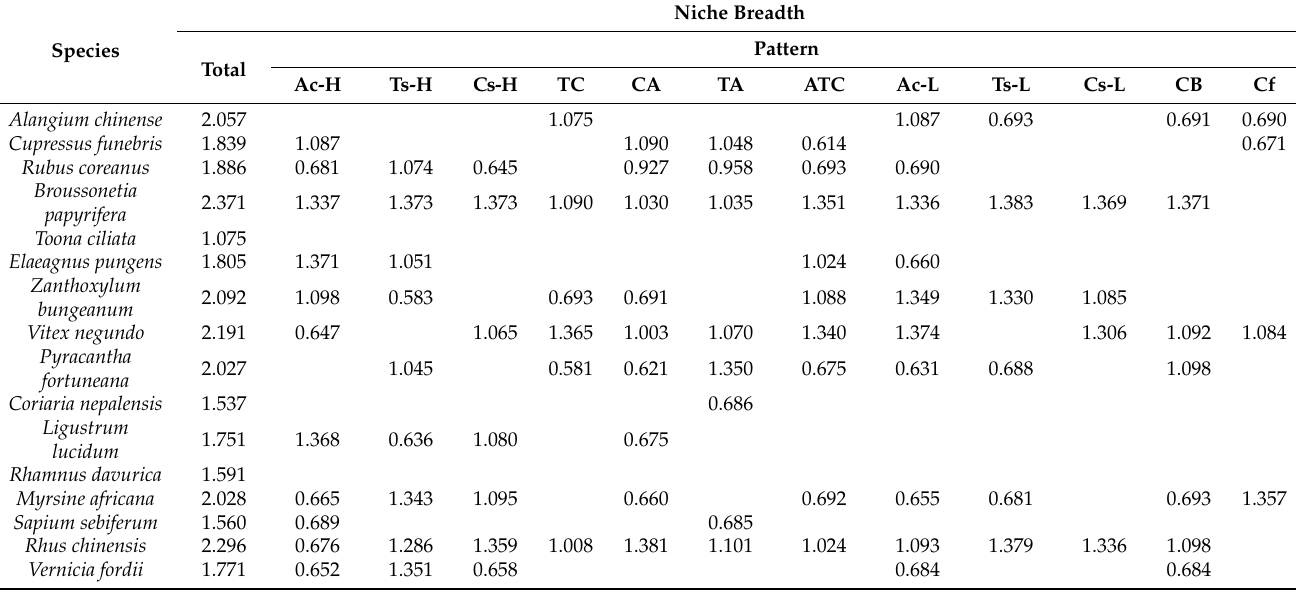
Table 2. The niche breadths of dominant shrub populations under different reconstruction patterns.